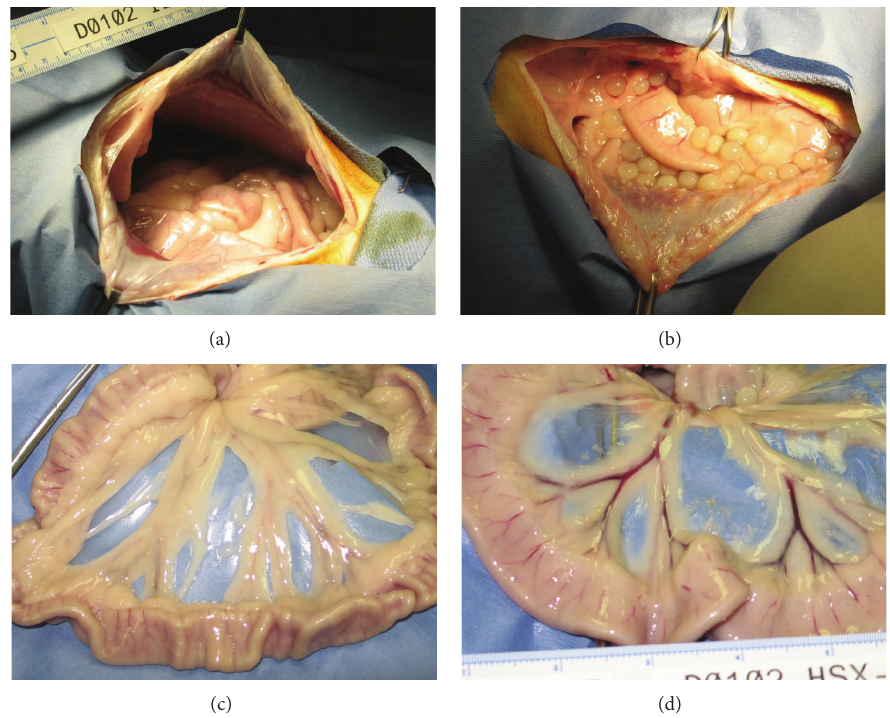
Figure 3: Macroscopic images taken at necropsy for a nonimplant control animal [ILX-1; (a), (c)] and a porcine islet macrobead recipient [HSX-1; (b), (d)]. (a)-(b) were taken at the initial opening. (c)-(d) are images of the mesentery of both animals.